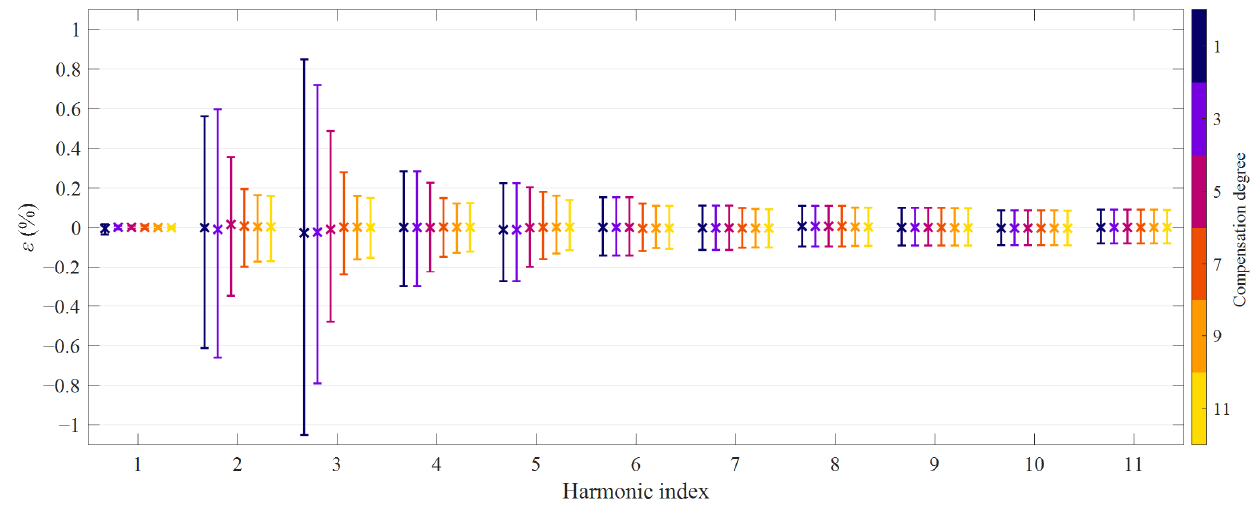
Figure 8. Ratio errors achieved with HD compensation degrees from 1 to 11: average values and 95th percentile bands; transformer CT1, class E 1 of primary current waveforms.